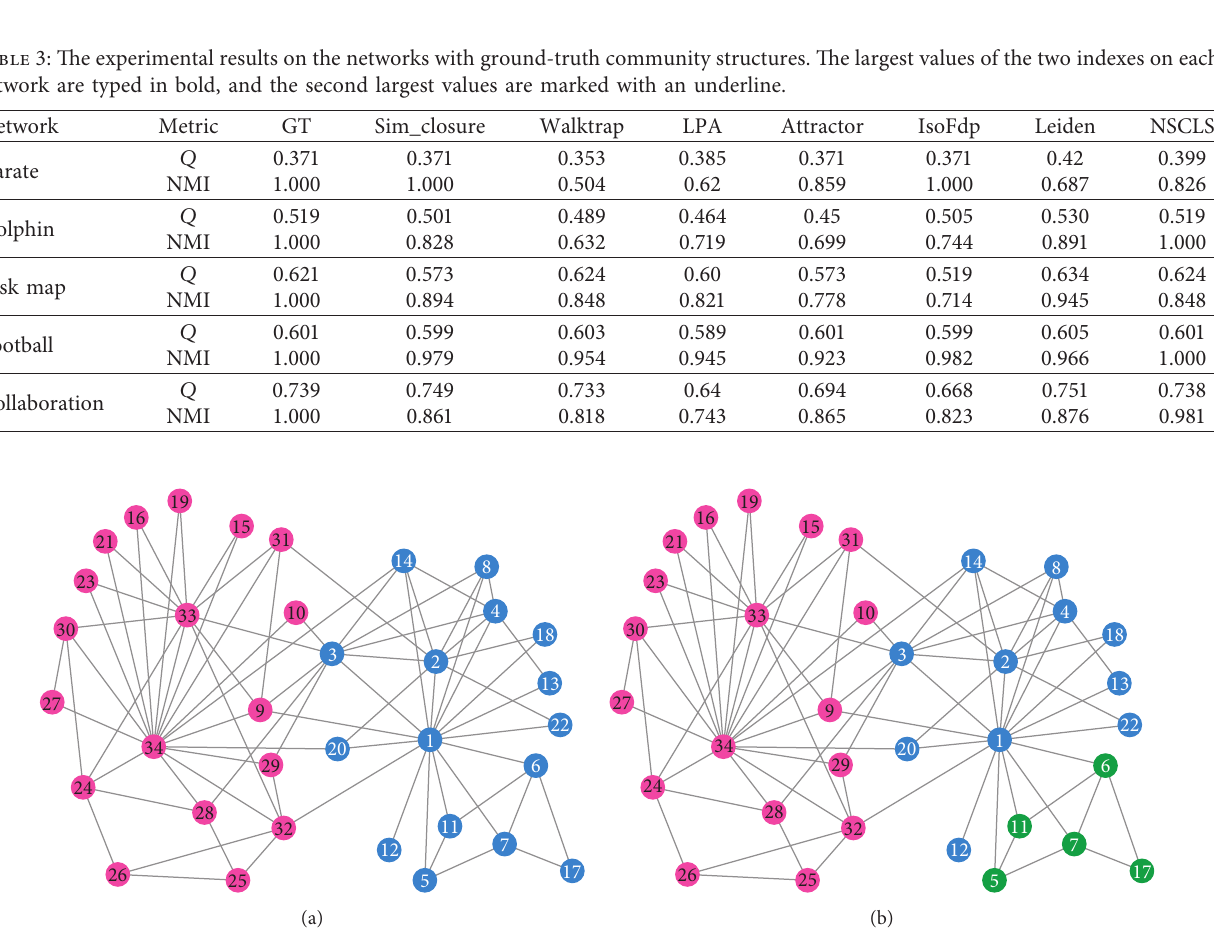
Figure 5: The Karate club network: (a) the ground-truth community structure; (b) the community structure detected by NSCLS.